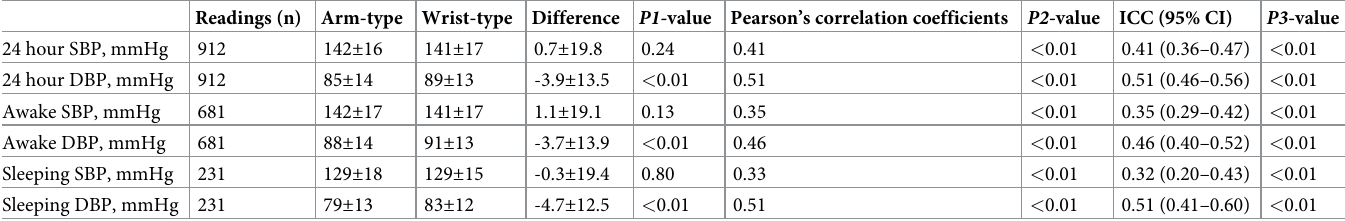
Table 3. Comparison of average BP levels provided by the two monitors (n =